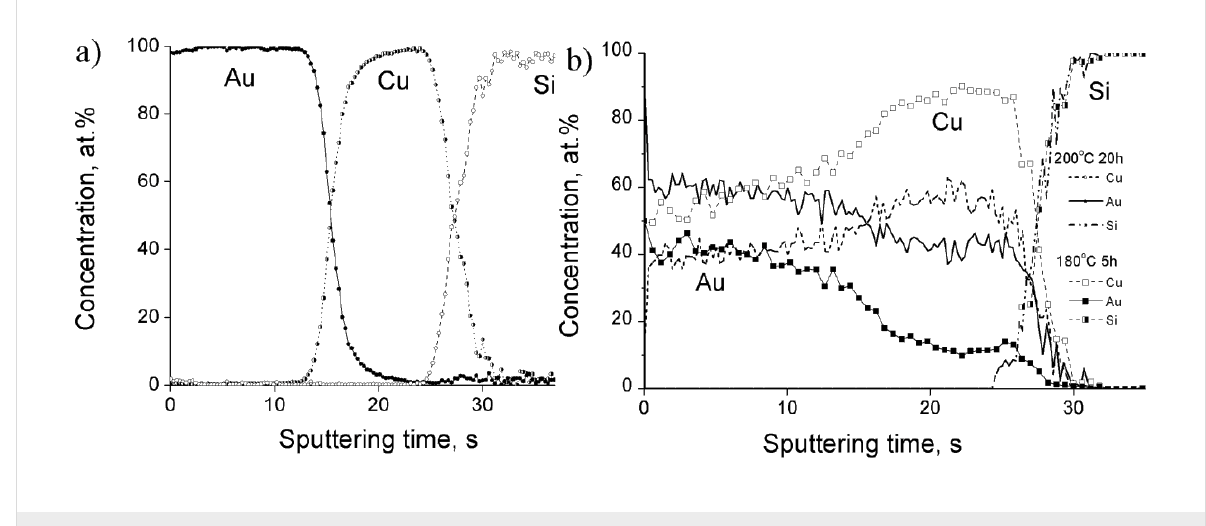
Figure 7: Concentration profiles of Au(25nm)/Cu(12nm) system a) as deposited sample and b) annealed samples.